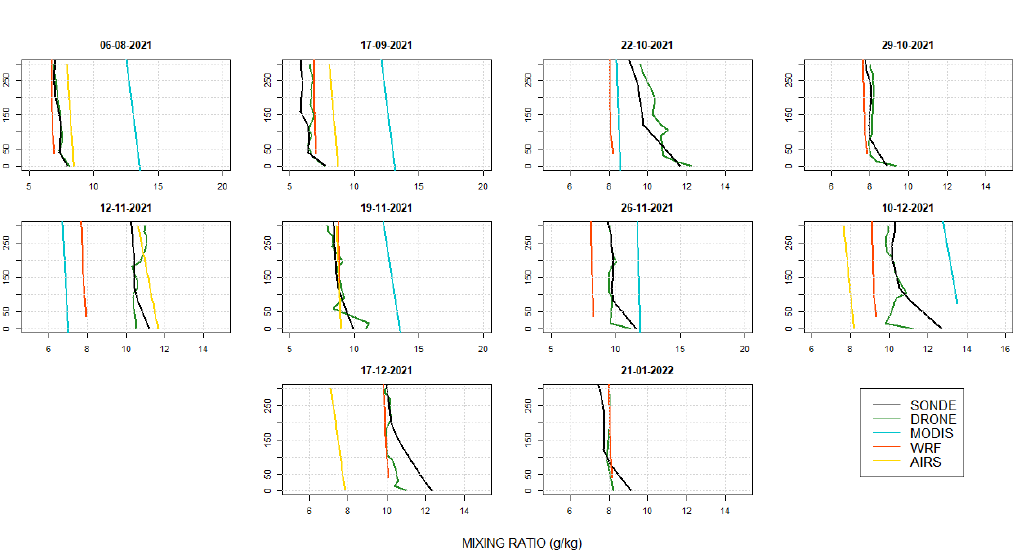
Figure A3. Mixing ratio profiles measured with radiosonde (black), drone (green), MODIS (sky- blue), AIRS (yellow), and WRF (orange) up to 15,000 magl. for 10 measurement events. Appendix A.4.